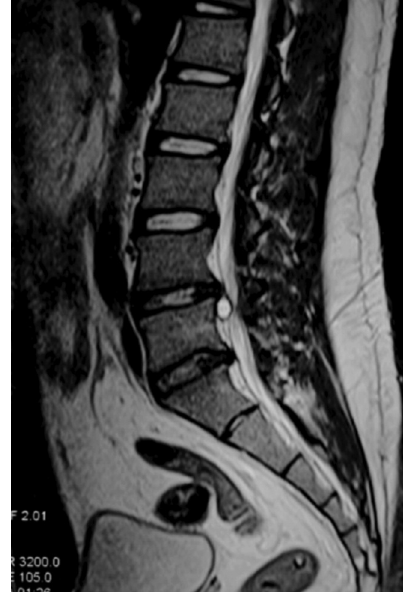
Intraoperative endoscopic image of the discal cyst Fig. 2: (indicated by